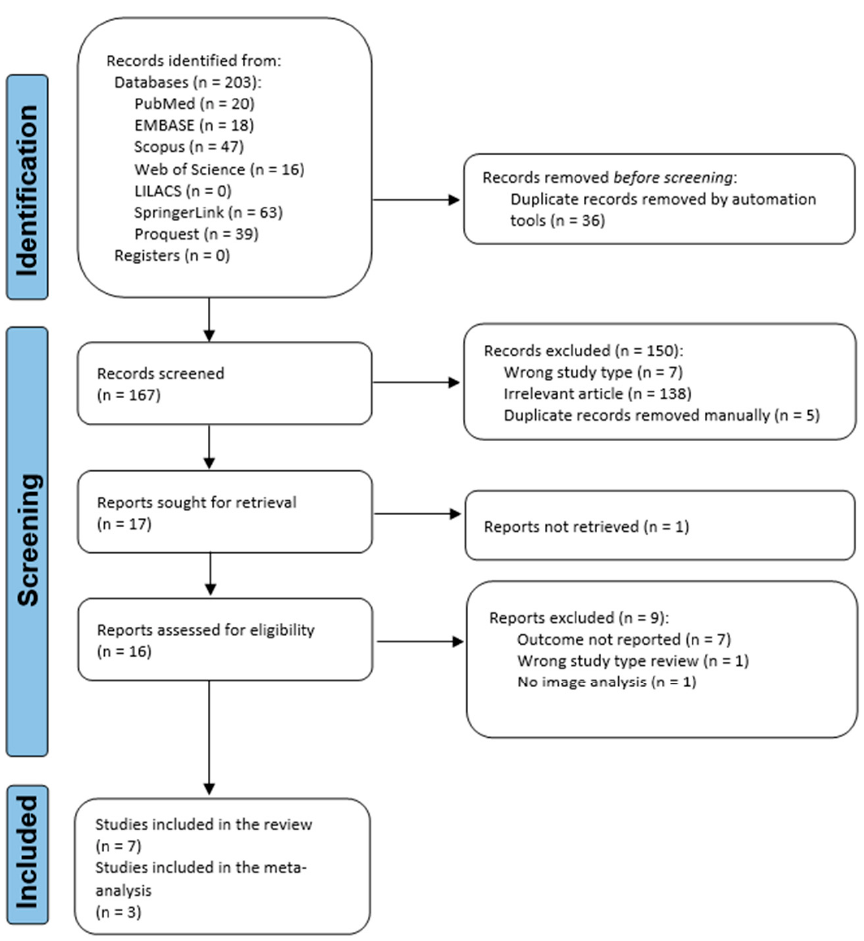
Figure 1. Flowchart of the identification, screening, and inclusion of articles in the systematic